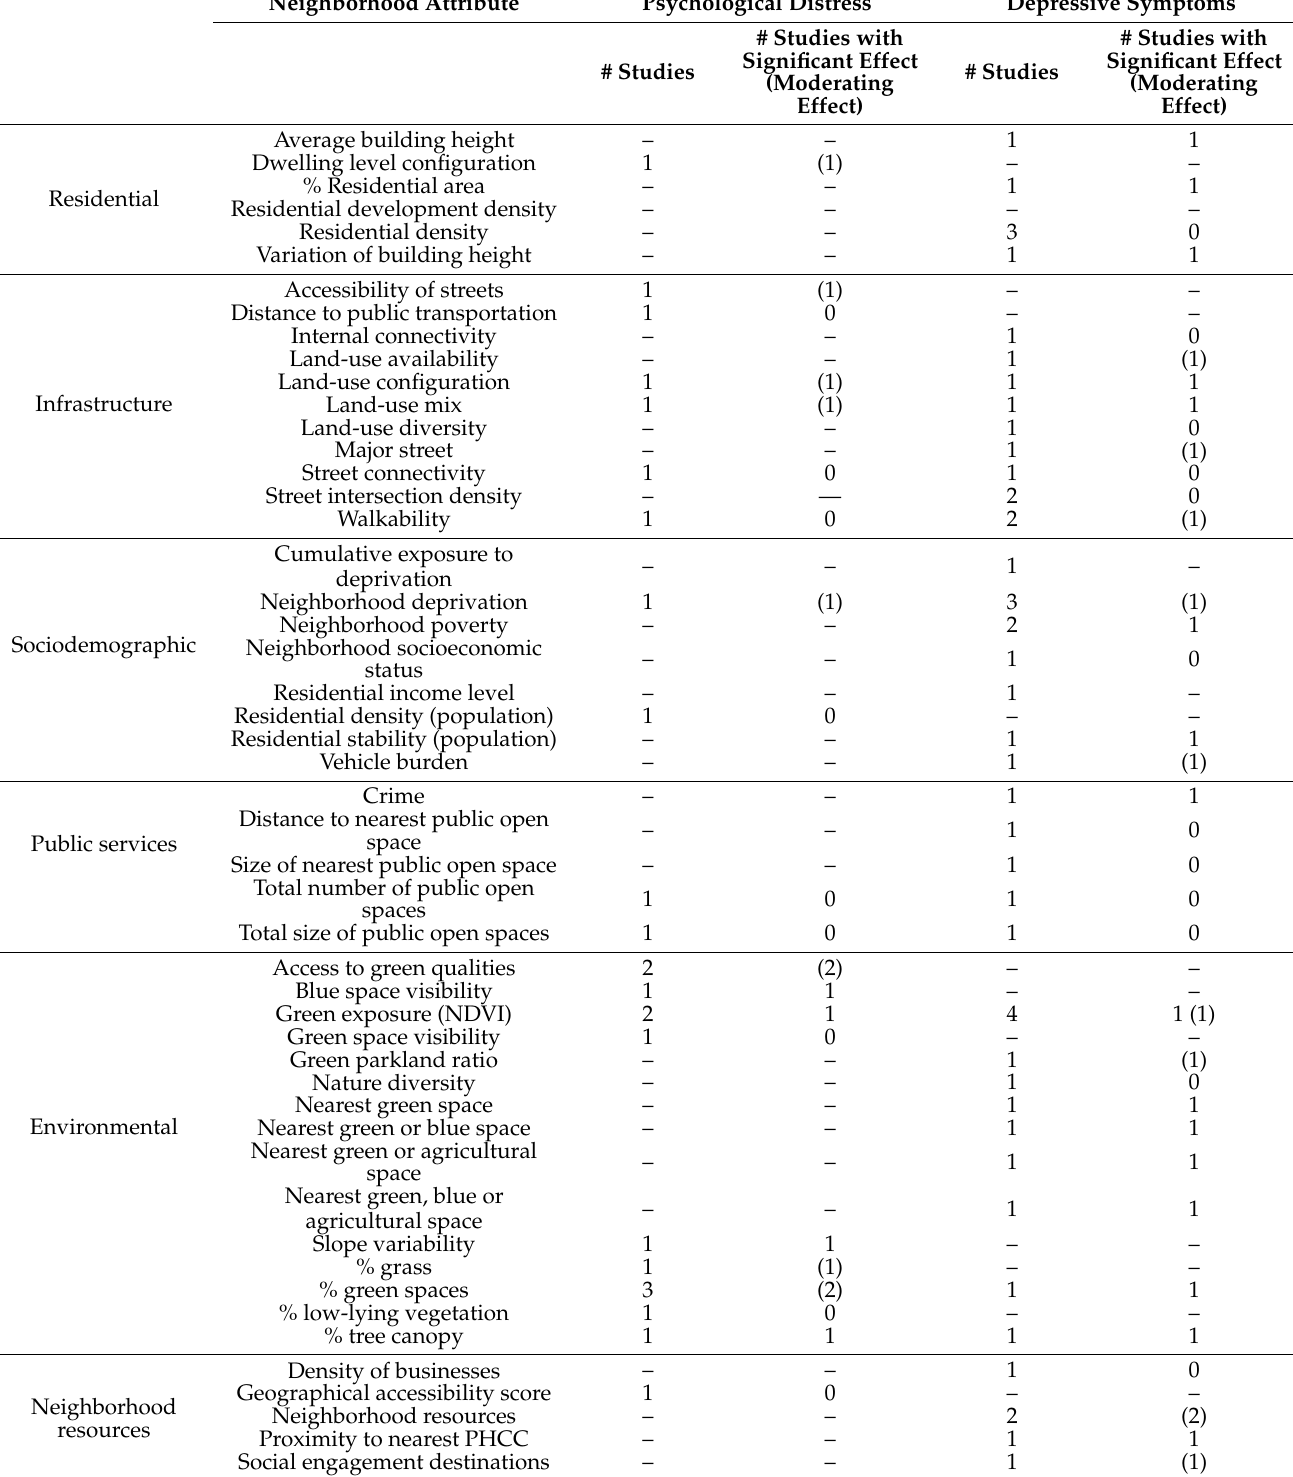
Table 5. Neighborhood attributes significantly related to mental health